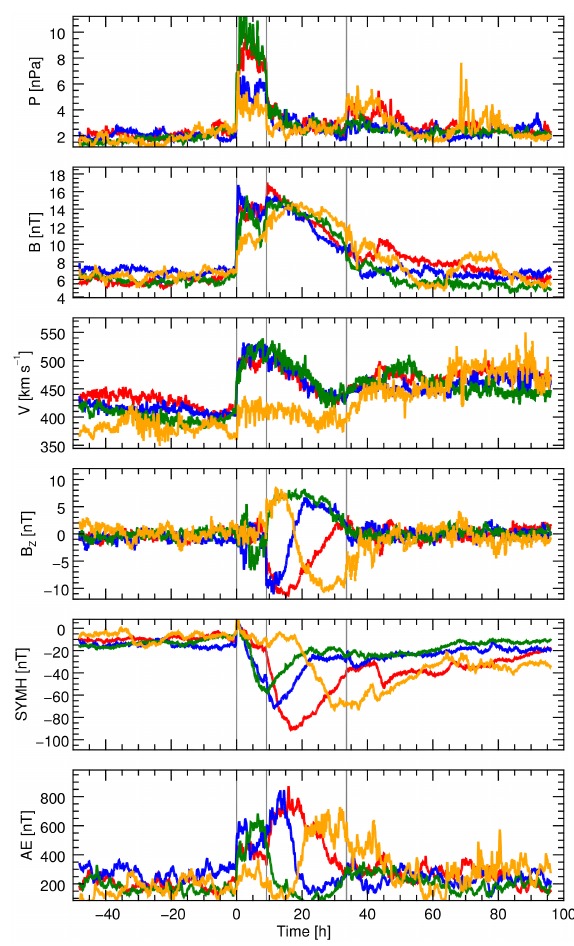
Figure 4. SEAs of four SW parameters ( B , P , V , B Z ) and two geomagnetic indices (SYM-H and AE) for 69 magnetic clouds be- tween 1996 and 2008. The three vertical lines are the epoch times indicating (respectively from left to right) the onset of the sheath, the onset of the ICME, and the end of the ICME. The different col- ors correspond to different polarities of magnetic clouds: full north (17 events) in green, north–south (9) in orange, south–north (16) in blue, and full south (27) in